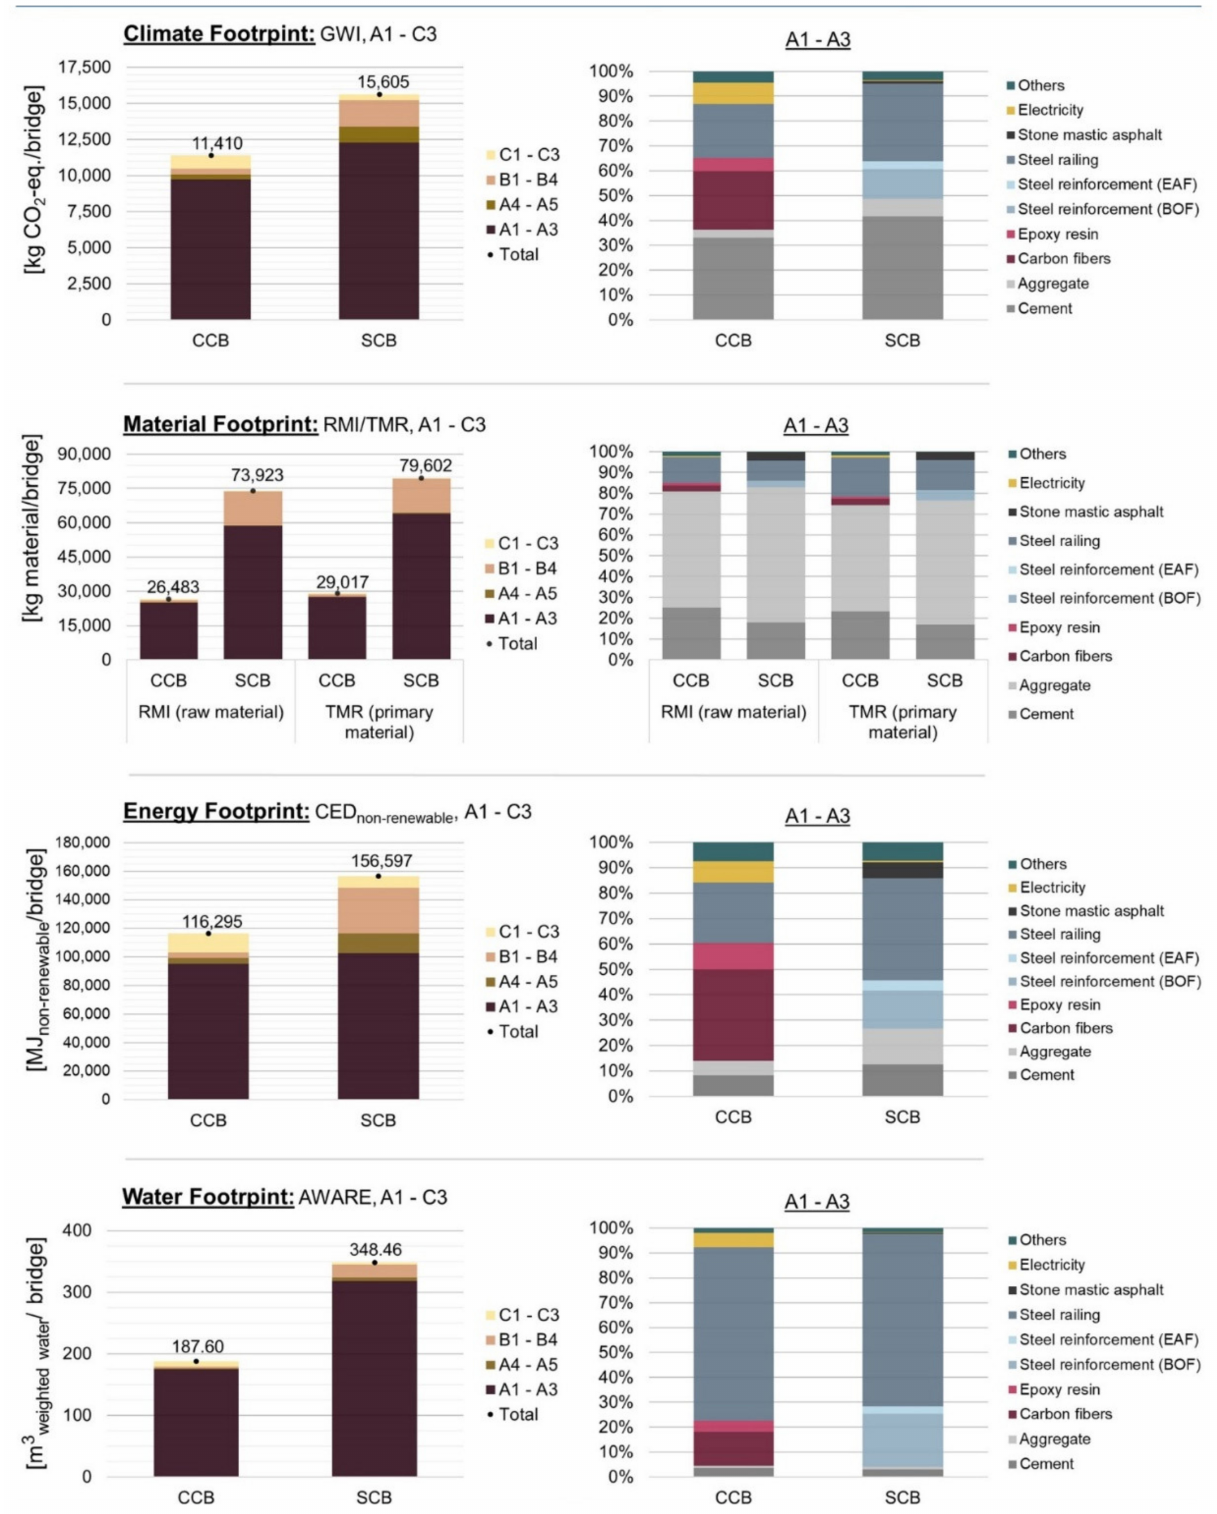
Figure 3. Climate, material, energy, and water footprints of a pedestrian bridge made from carbon concrete (CCB) and from reinforced concrete (SCB). A1-C3: entire life-cycle, A1-A3: production phase. GWI: global warming impact. RMI: raw material input. TMR: total material requirement. CED: cumulated energy demand. AWARE: available water remaining. EAF: electric arc furnace. BOF: basic oxygen